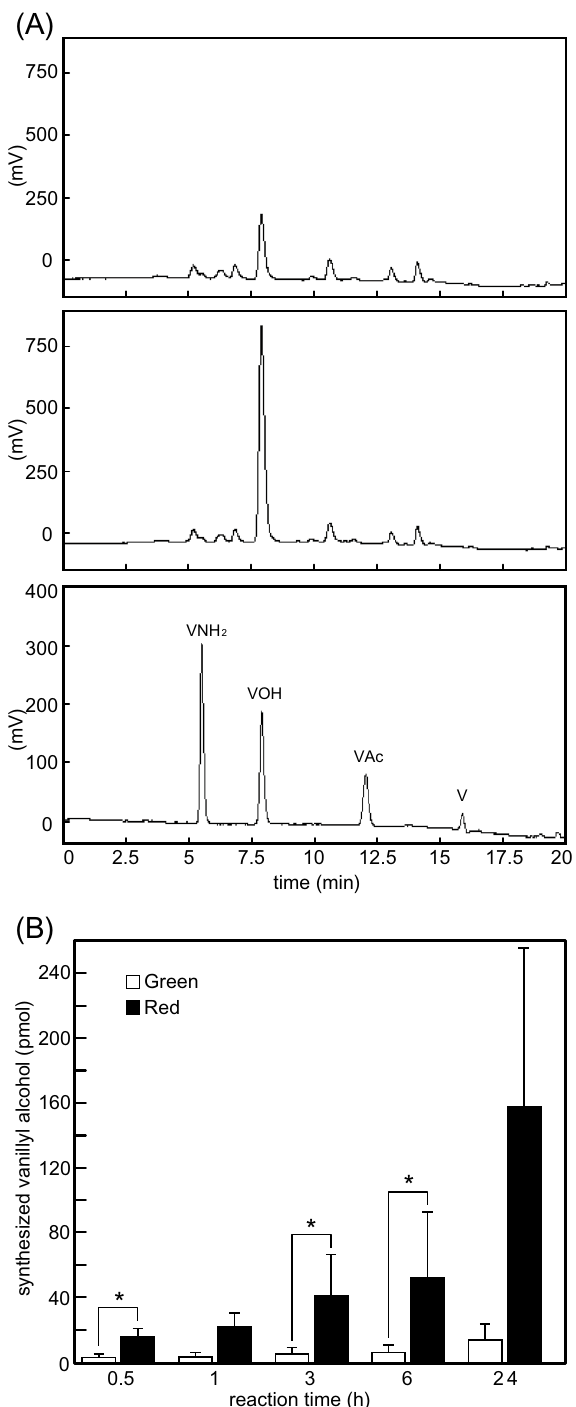
Figure 2. Vanillin reduction activity of CH-19 Sweet placental extracts. ( A ) Typical chromatograms for the HPLC analysis of vanillyl alcohol production in a green fruit placental extract (fluorescence detection: 280 nm excitation wavelength and 320 nm emission wavelength). Vanillyl alcohol contents before the reaction (top) and after a 60-min reaction (middle) are presented. Vanillin derivatives (V: vanillin; VOH: vanillyl alcohol; VNH 2 : vanillylamine; and Vac: vanillic acid) were separated by HPLC as controls (bottom). ( B ) Amount of vanillyl alcohol synthesized by placental extracts at each reaction time-point. White and black bars indicate the results for the green fruits ( n = 7) and red fruits ( n = 5), respectively. Asterisks indicate a significant difference ( P < 0.05) as determined by Welch’s t